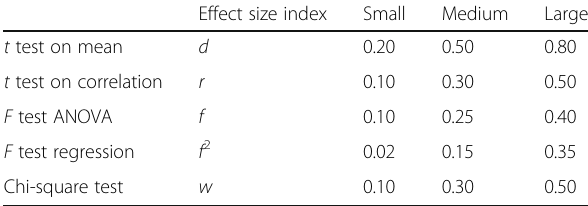
Table 8 Cohen table of statistical power